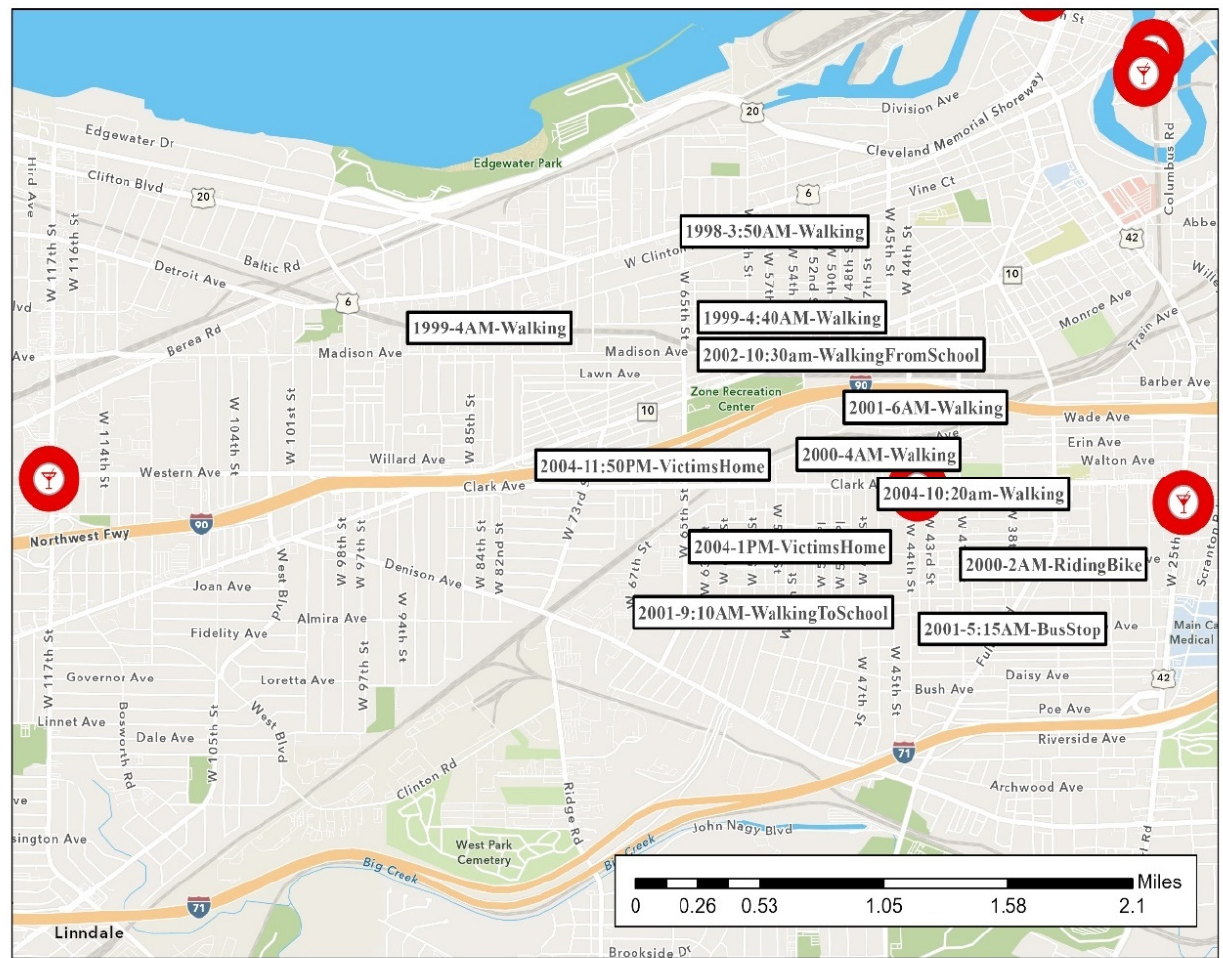
Figure 6. Strip Club Theory Map, Cleveland’s West Side (Strip Clubs Denoted With Red Martini Glass Symbols).